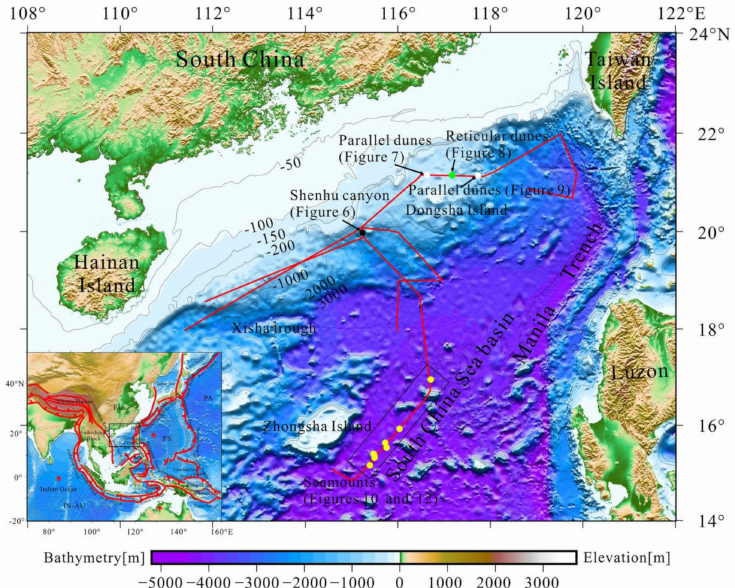
Figure 1. Bathymetric map in the South China Sea and the elevations in its surrounding area. The background bathymetric data is from the General Bathymetric Chart of the Oceans [40]. The geological setting is shown in the index map on the bottom-left. EU: Eurasian plate; PA: Pacific plate; PS: Philippine Sea plate; IN-AU: Indo-Australian plate. The geographic location and landform type of later Figures are shown in